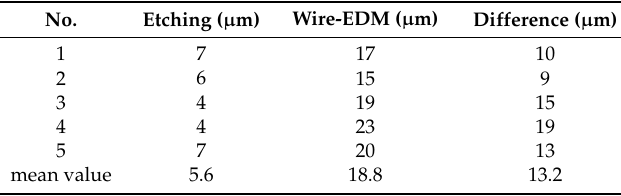
Table 11. Results of error in